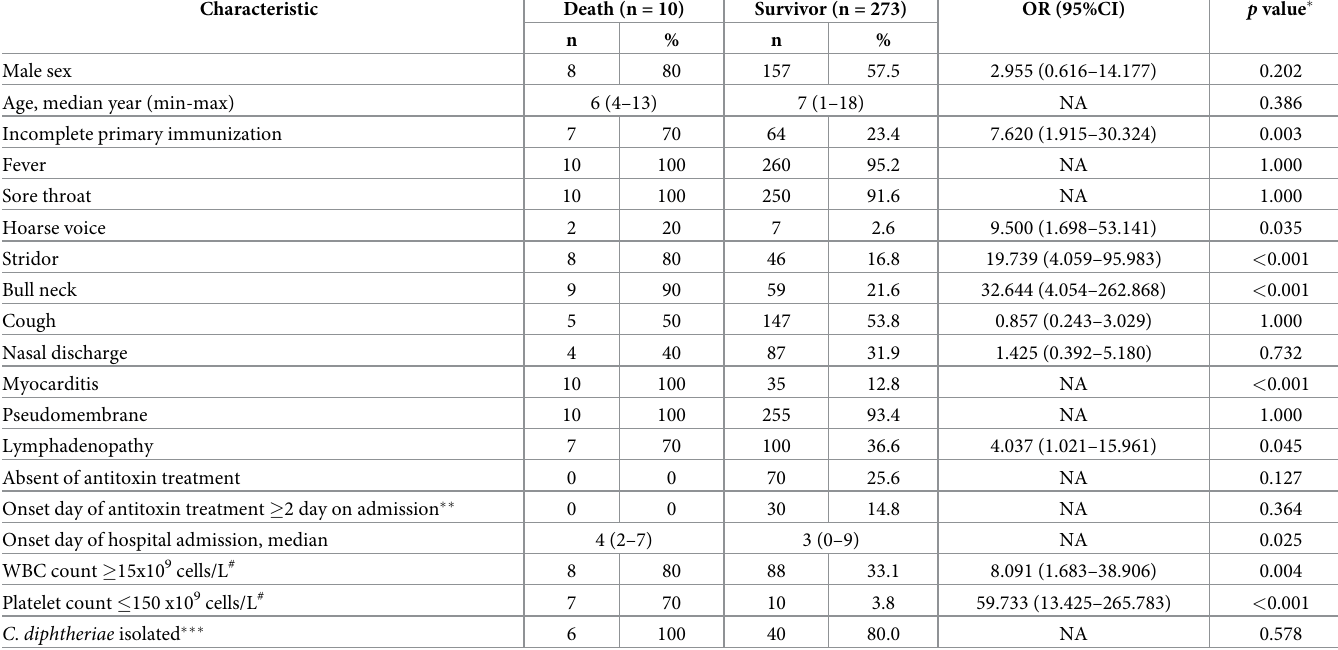
Table 3. Predictive factors suspected to affect mortality outcome (n =